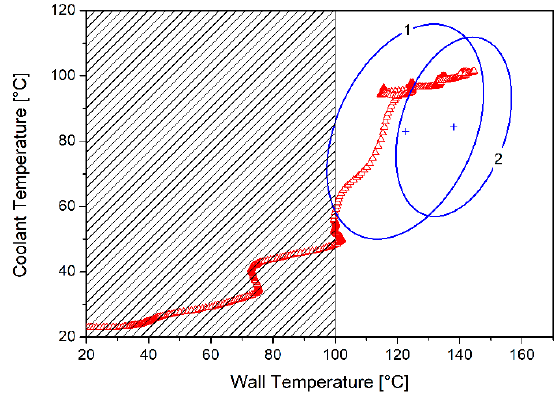
Figure 23. Coolant and wall temperatures for prolonged high load operation ( m(cid:4662) (cid:2916) = 9 kg/h).